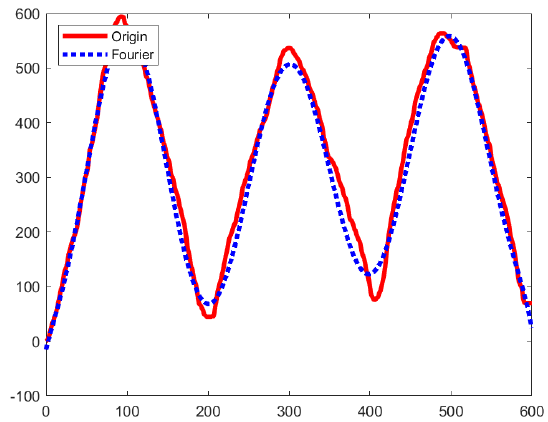
Figure 8. Curve fitting trajectory is expressed in the Fourier series.